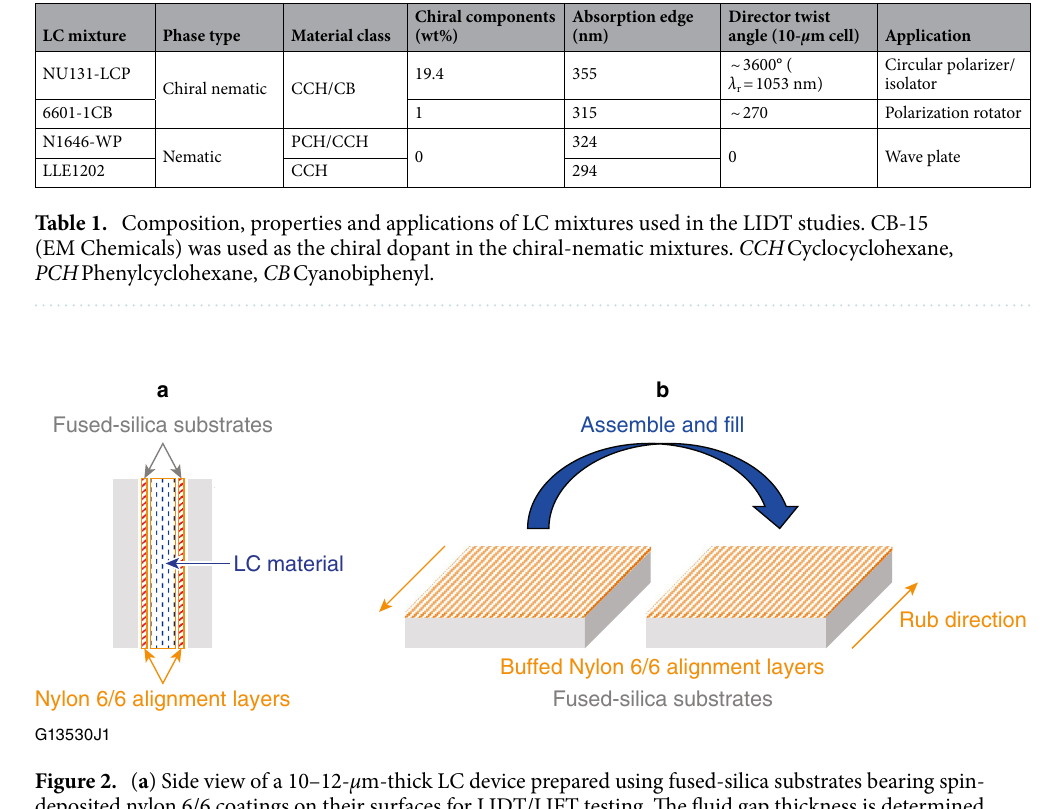
Figure 2. ( a ) Side view of a 10–12- µ m-thick LC device prepared using fused-silica substrates bearing spin- deposited nylon 6/6 coatings on their surfaces for LIDT/LIFT testing. The fluid gap thickness is determined by spacer beads embedded in the epoxy resin used to bond the substrates to each other. ( b ) For LC wave-plate devices, the nylon 6/6 layers were buffed in opposite directions (antiparallel) prior to assembly to minimize the effect of LC molecular pre-tilt at the surfaces and achieve monodomain